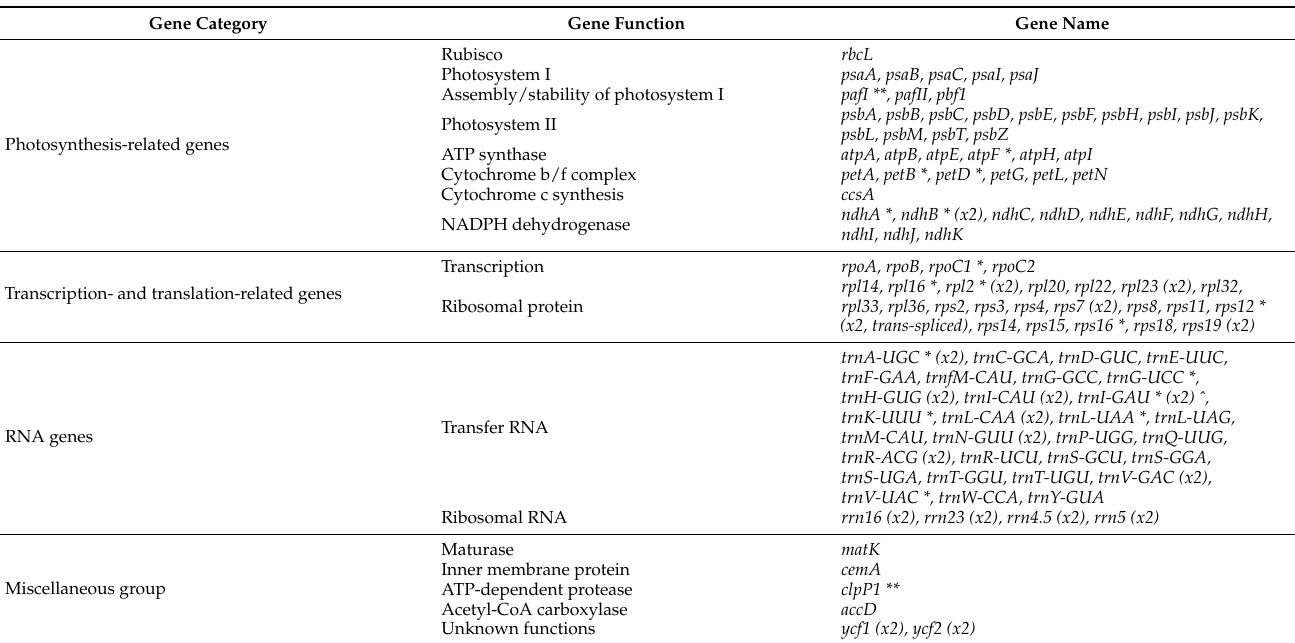
Table 2. Annotated genes in the nine Smilacaceae chloroplast